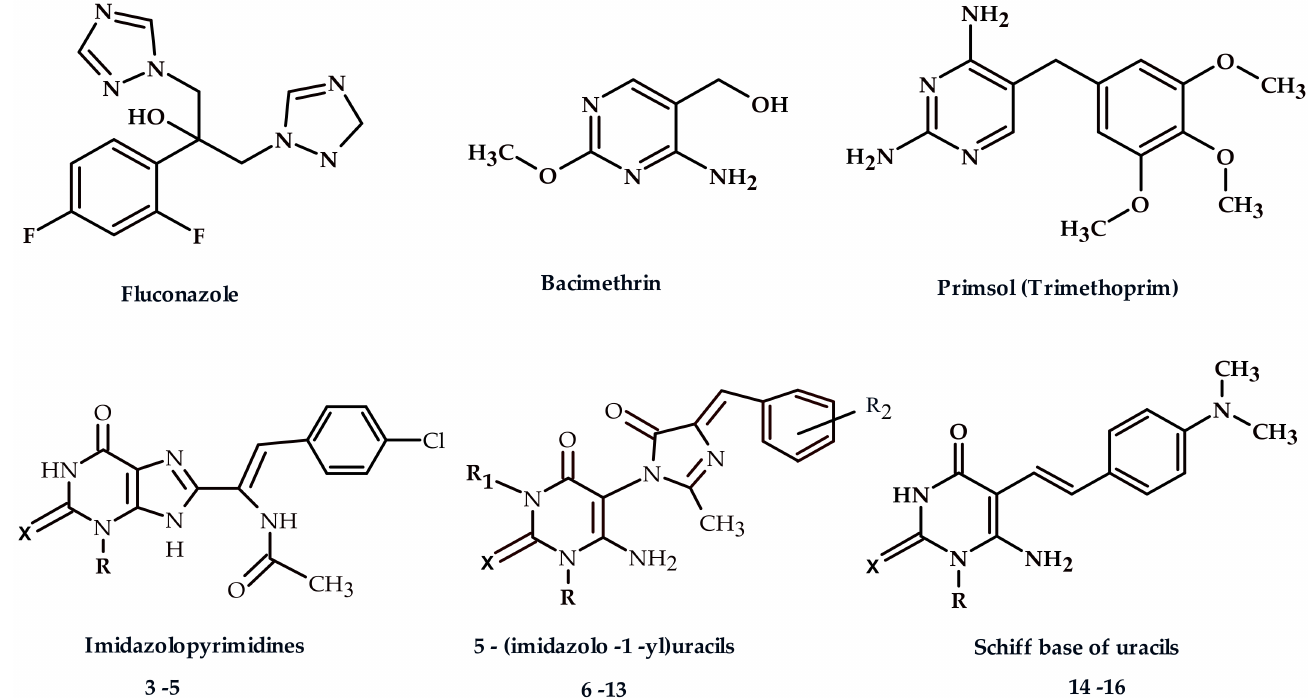
Scheme 1. Chemical structures of Fluconazole, Bacmethrin, and Prismsol, as authentic drugs, and the current synthesized compounds “imidazolopyrimidine-2,4-diones, 5- (imidazole-1-yl) uracils and Schiff base of